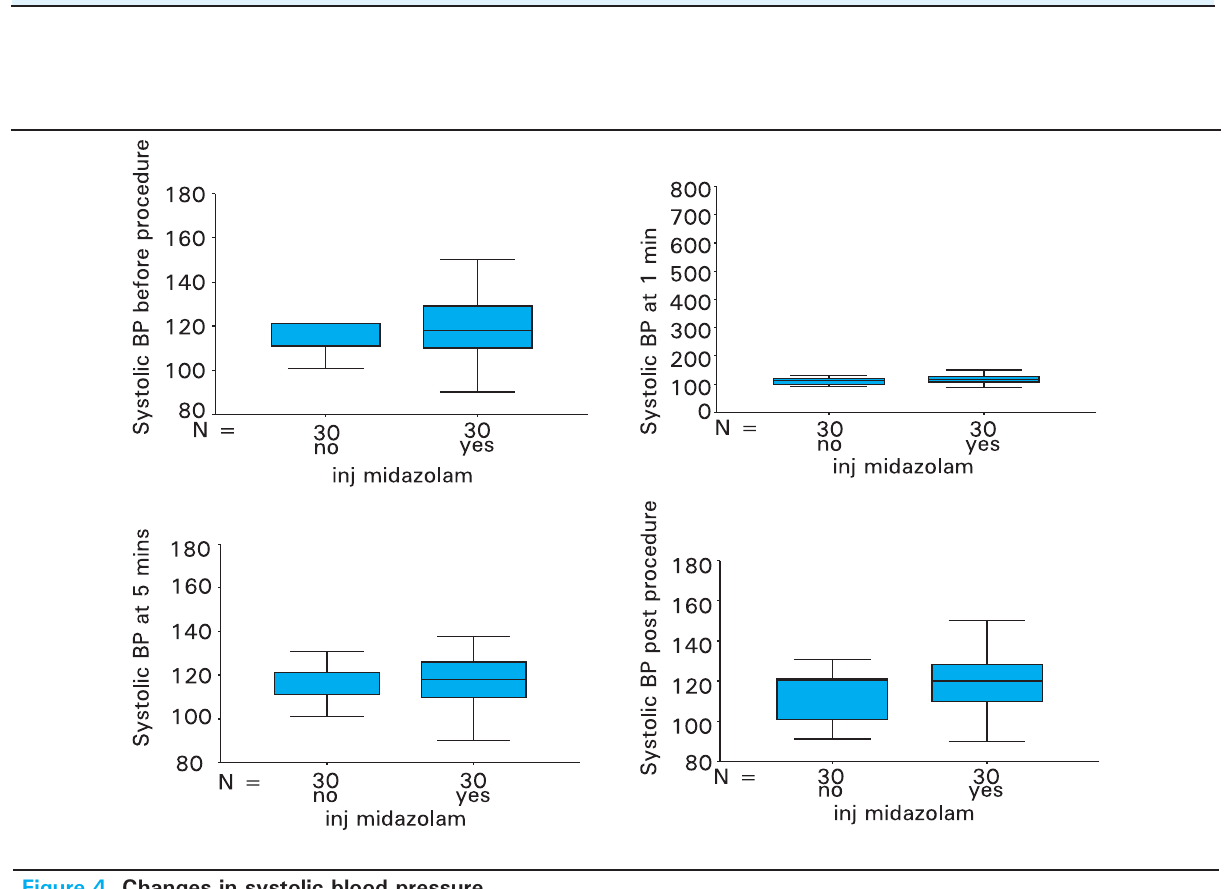
Figure 3. Changes in pulse rate (per minute) at different stages of procedure